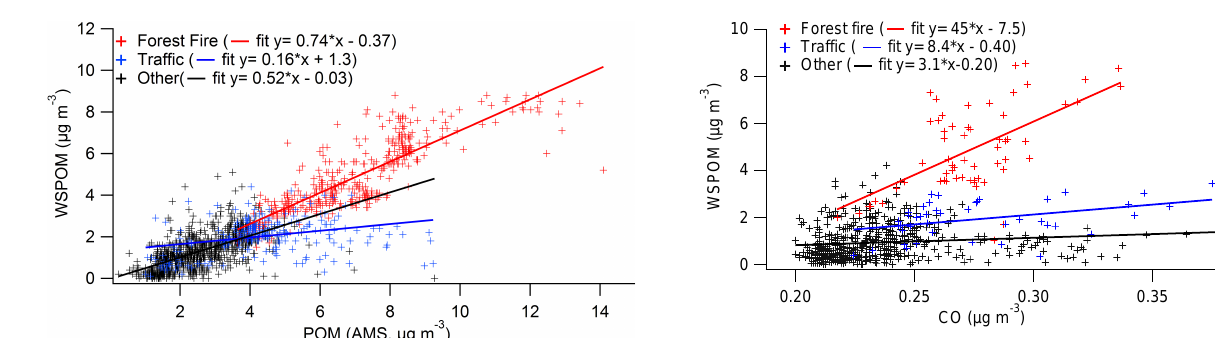
Fig. 3. WSPOM versus POM for different sources of WSPOM. The equations ( y = kx + b ) of fitted curves represented after each legend.